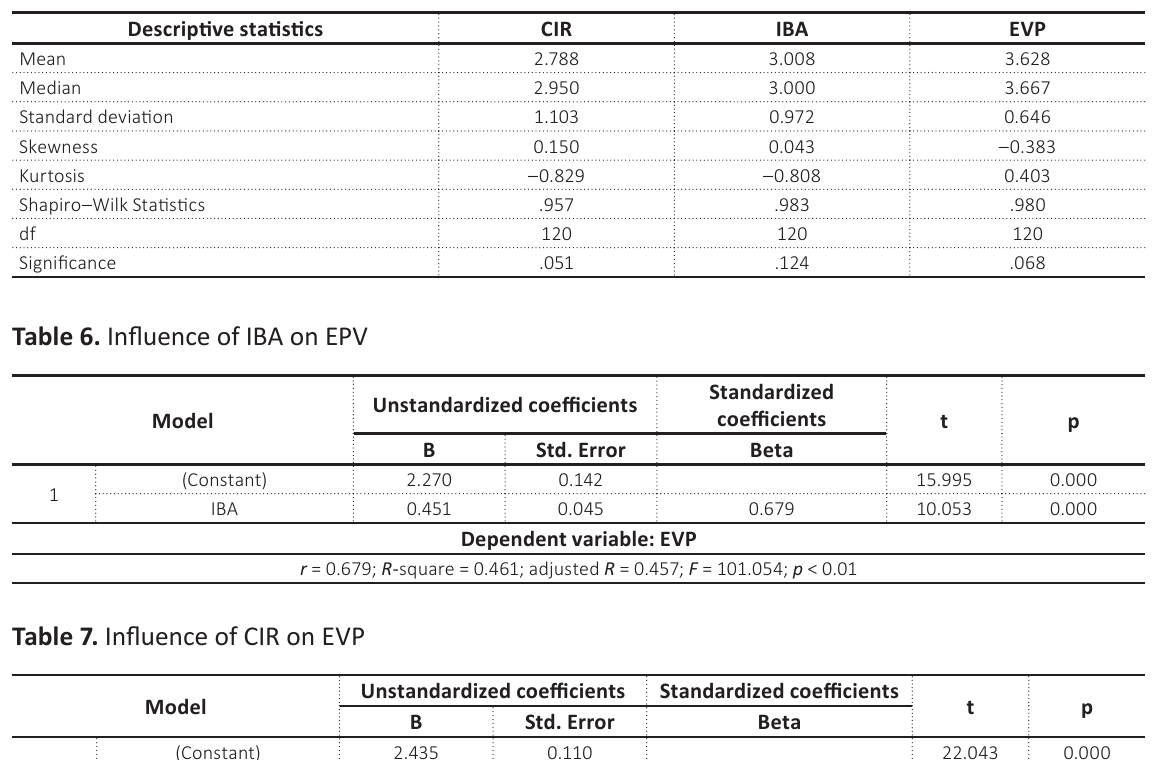
Table 5. Descriptive statistics and normal distribution tests